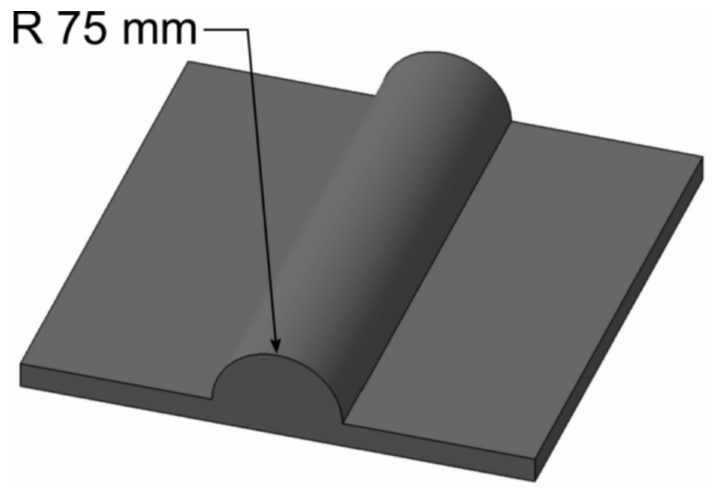
Figure 7. Crush plate for the module as per SAND2017-6925:2017 [107]. For cell testing, GB/T 31485-2015:2015 [90] specifies that the semi-cylindrical impactor should have a radius of 75 mm and the length should be more than the dimension of the cell (see Figure 2), while FreedomCAR:2006 [92] and SAE J2464:2009 [89], state